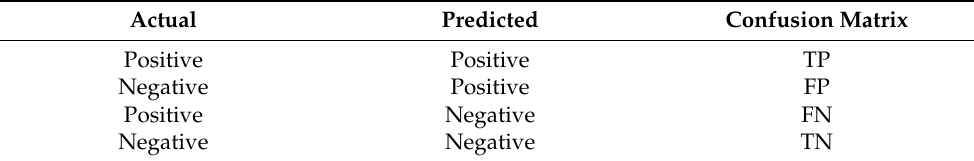
Table 7. The confusion matrix.